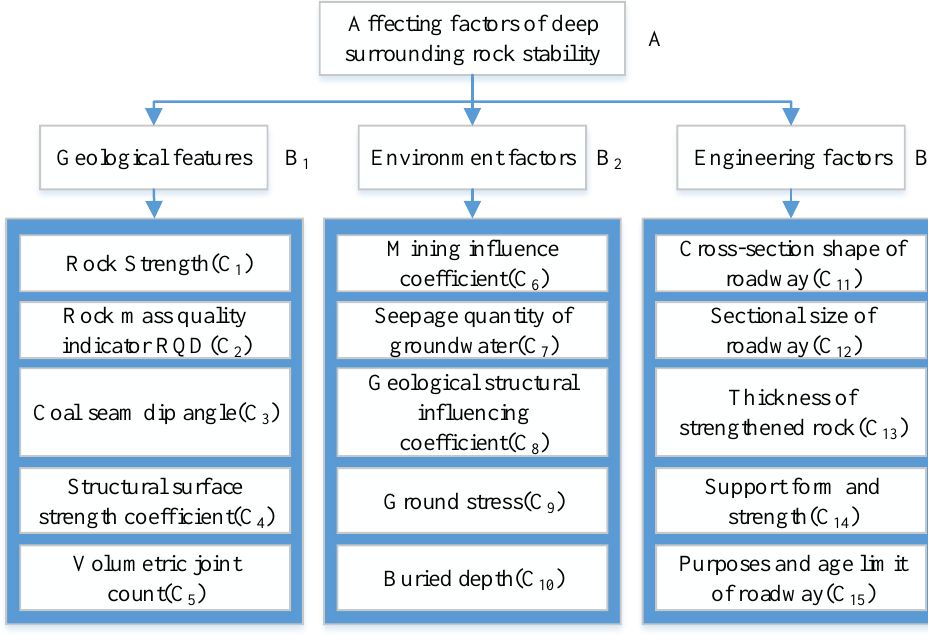
Figure 2. Hierarchy structure model for the deep surrounding rock stability affecting factors.